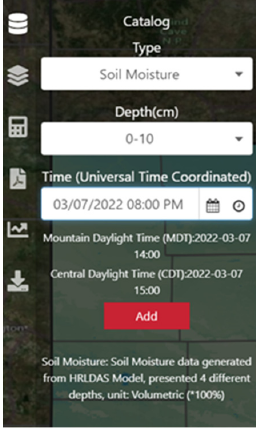
Figure 4. Soil moisture map in Nebraska on 7 March 2022.